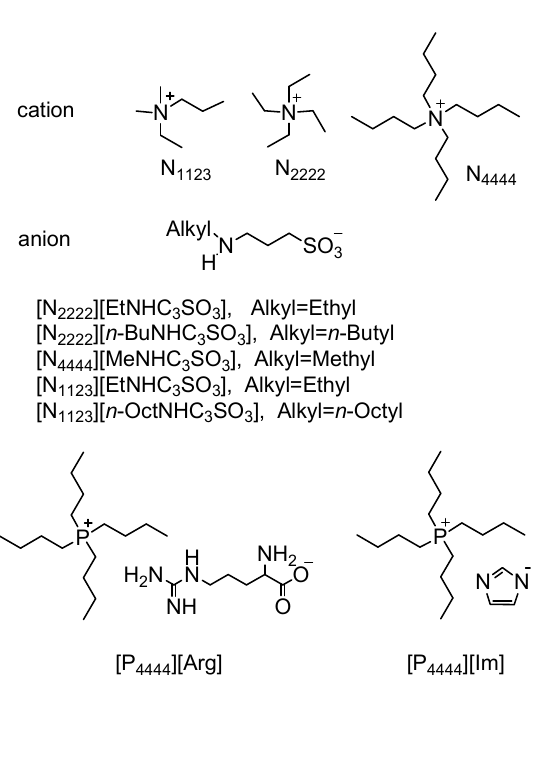
Figure 1. Structures of functionalized